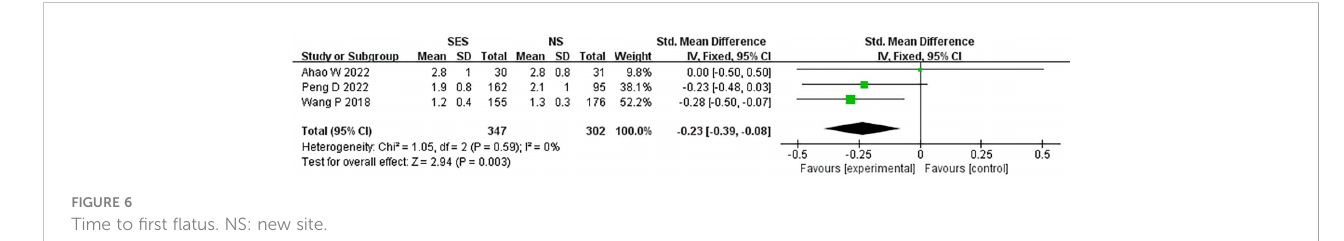
FIGURE 6 Time to fi rst fl atus. NS: new site.